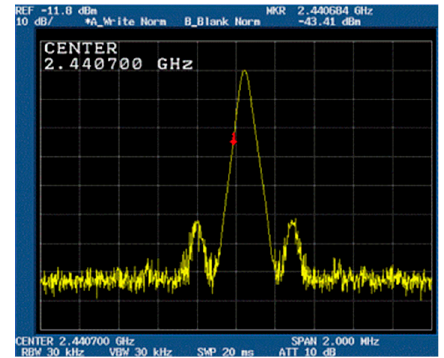
Figure 13. Measured output spectrum.